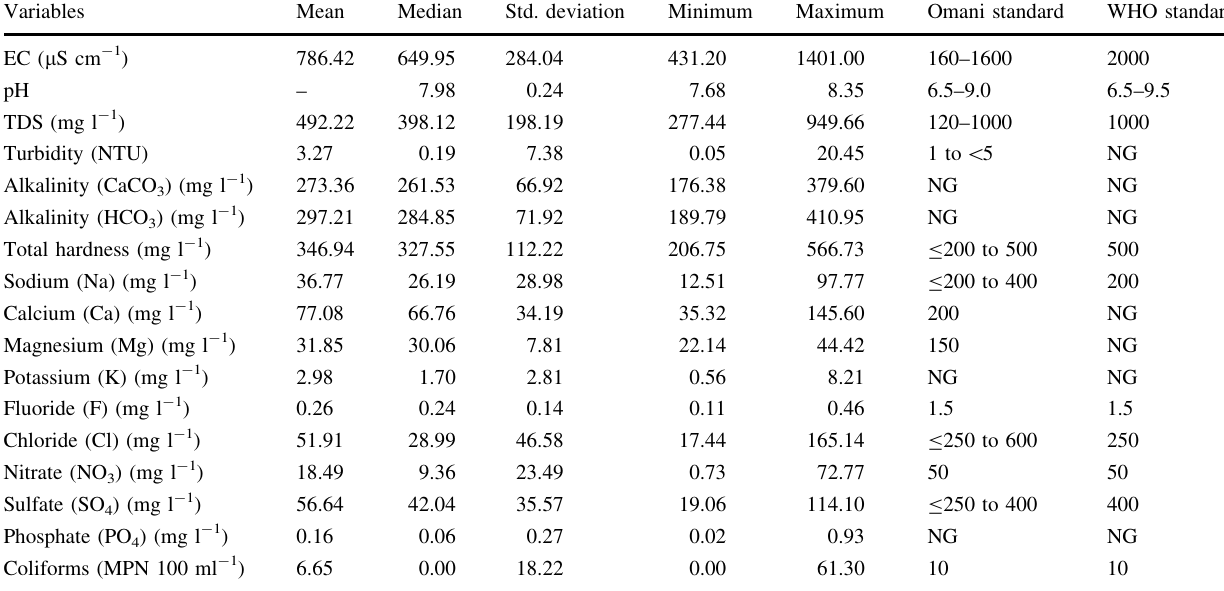
Table 4 Mean, median, standard deviation, minimum and maximum of groundwater quality variables of the study area in 2012–2013